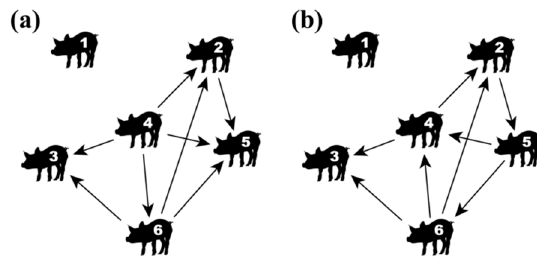
Figure 1. Example illustration of ( a ) an initiator-receiver network and ( b ) a winner-loser network within the same group of animals. In the initiator-receiver network, the edges point from the initiator to the receiver of an agonistic interaction. In the winner-loser network, the edges point from the winner to the loser of the agonistic interaction.